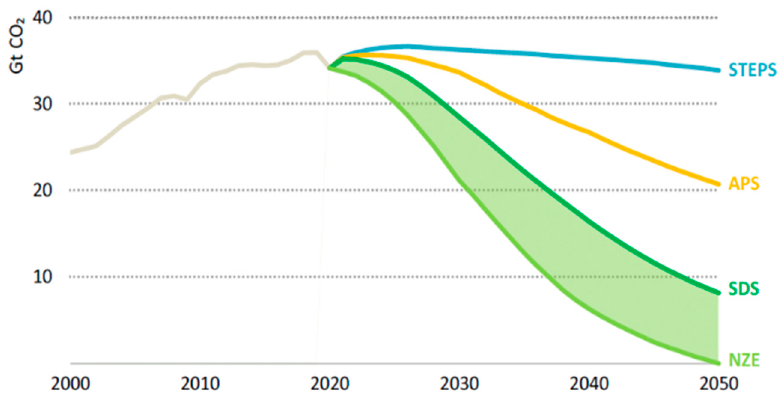
Figure 1. CO 2 emissions in the World Energy Outlook—2021 scenario over time (Source: Interna- tional Energy Agency (IEA). World Energy Outlook 2021) Note: STEPS = Stated Policies Scenario; APS = Announced Pledges Scenario; SDS = Sustainable Development Scenario; NZE = Net Zero Emissions by 2050 Scenario.